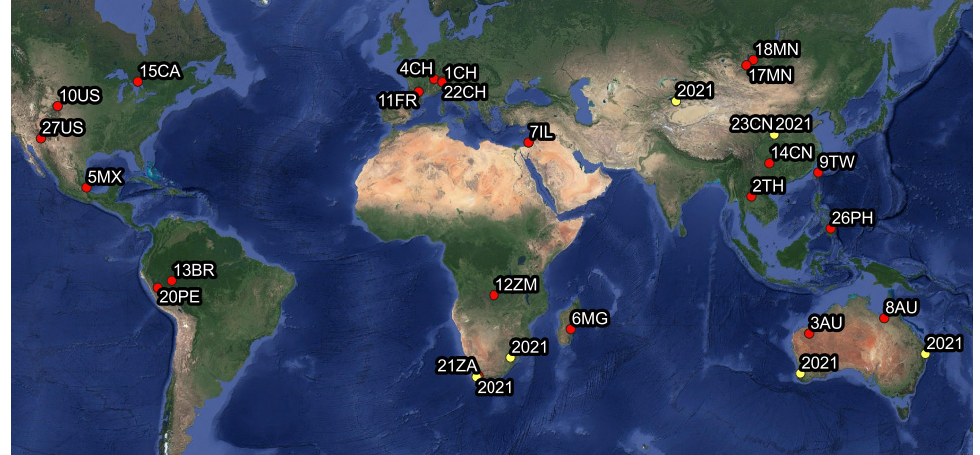
Figure 5. Map of the sampling sites of the 41 leafhopper specimens found positive for the presence of phytoplasmas, 35 individuals from the present study (points in red) and 6 individuals from the previous study [3] (points in yellow, 2021)(Trivellone et al. 2021). Map created QGIS 3.8 and